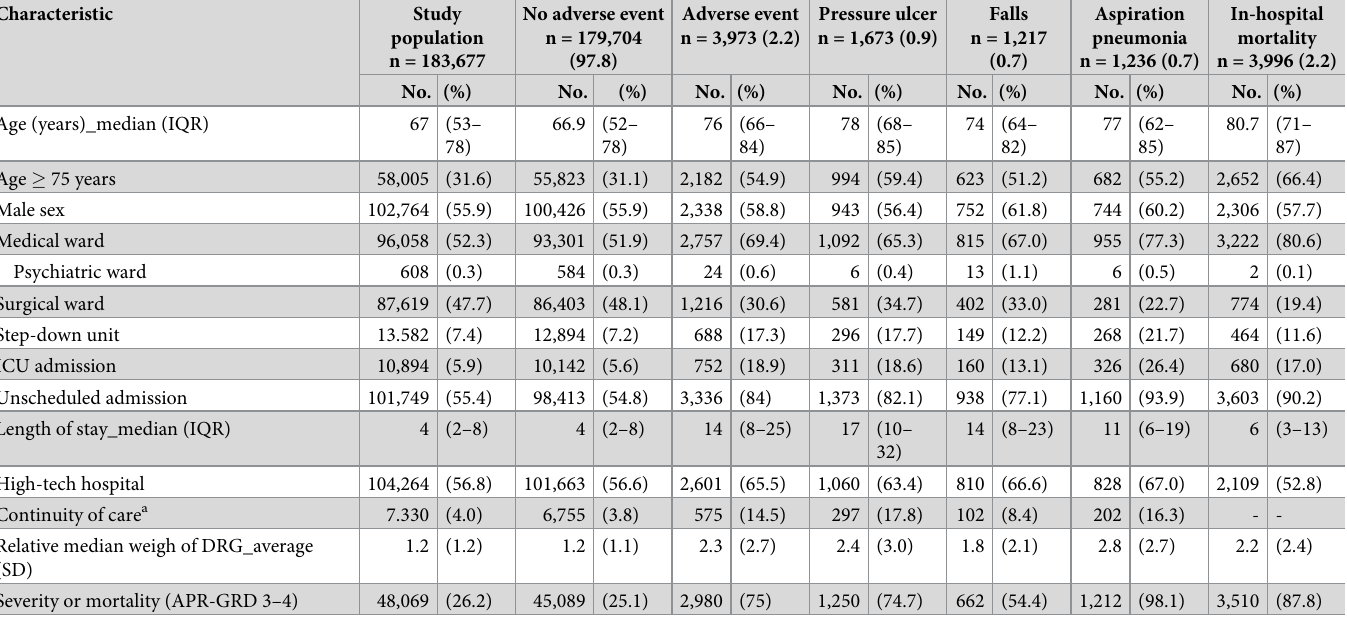
Table 1. Baseline characteristics of adult patients according to adverse events and in-hospital